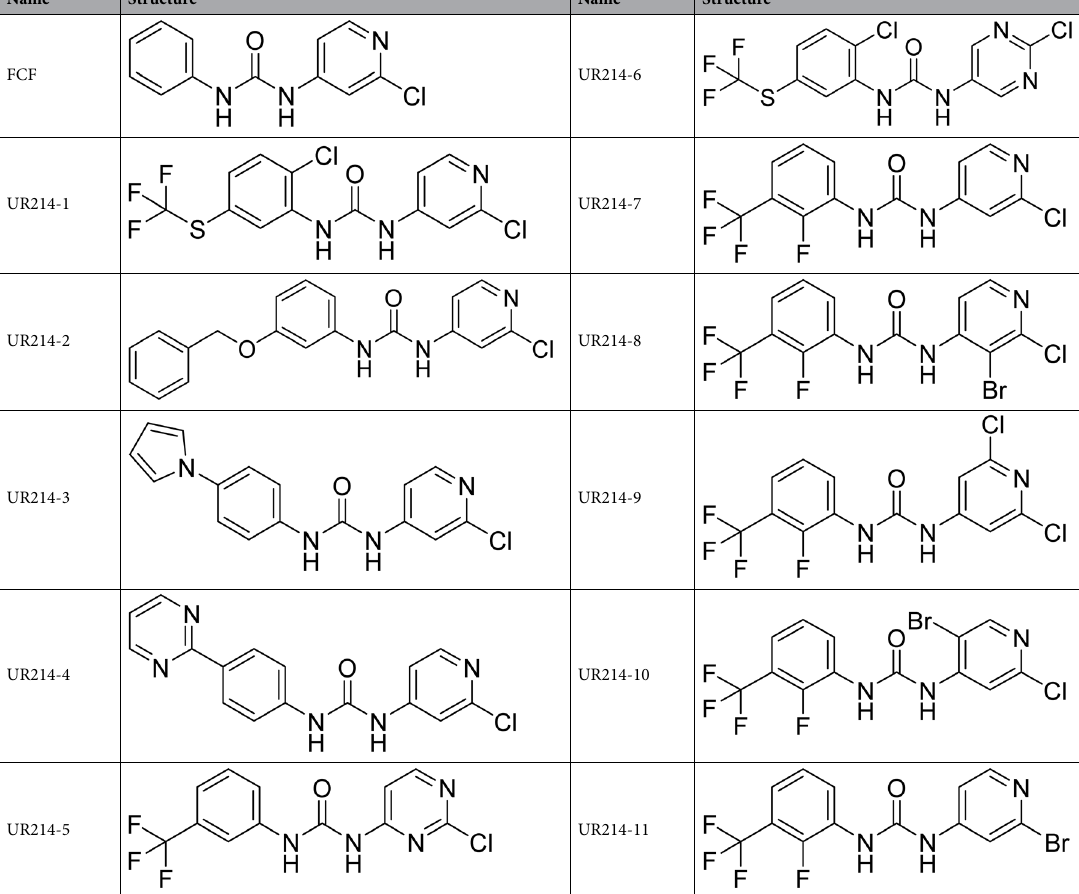
Table 1. The structure of FCF and its newly derived